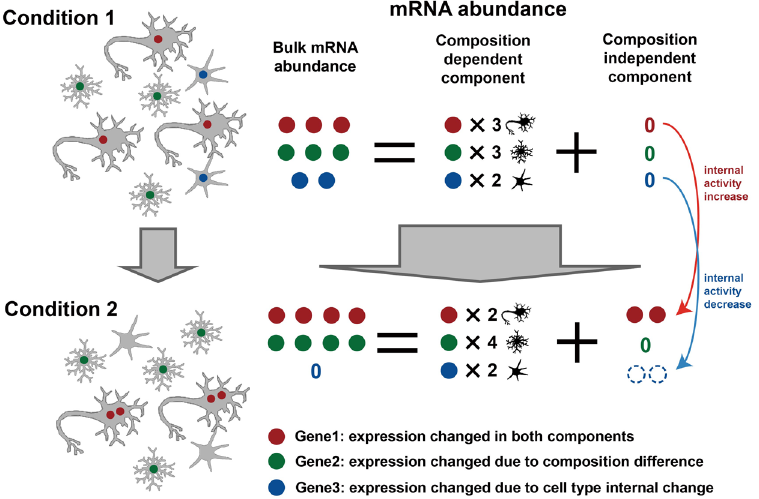
Figure 2. Schematic representation of gene expression dissection into composition-dependent and composition-independent components. Circles with different colors represent mRNA products of different genes. Dashed hollow circles in composition-independent components represent “negative” expressions, i . e . the observed expression level in bulk tissue is lower than the expected expression level when composition difference is assumed to be the only variable ( i . e . composition-dependent